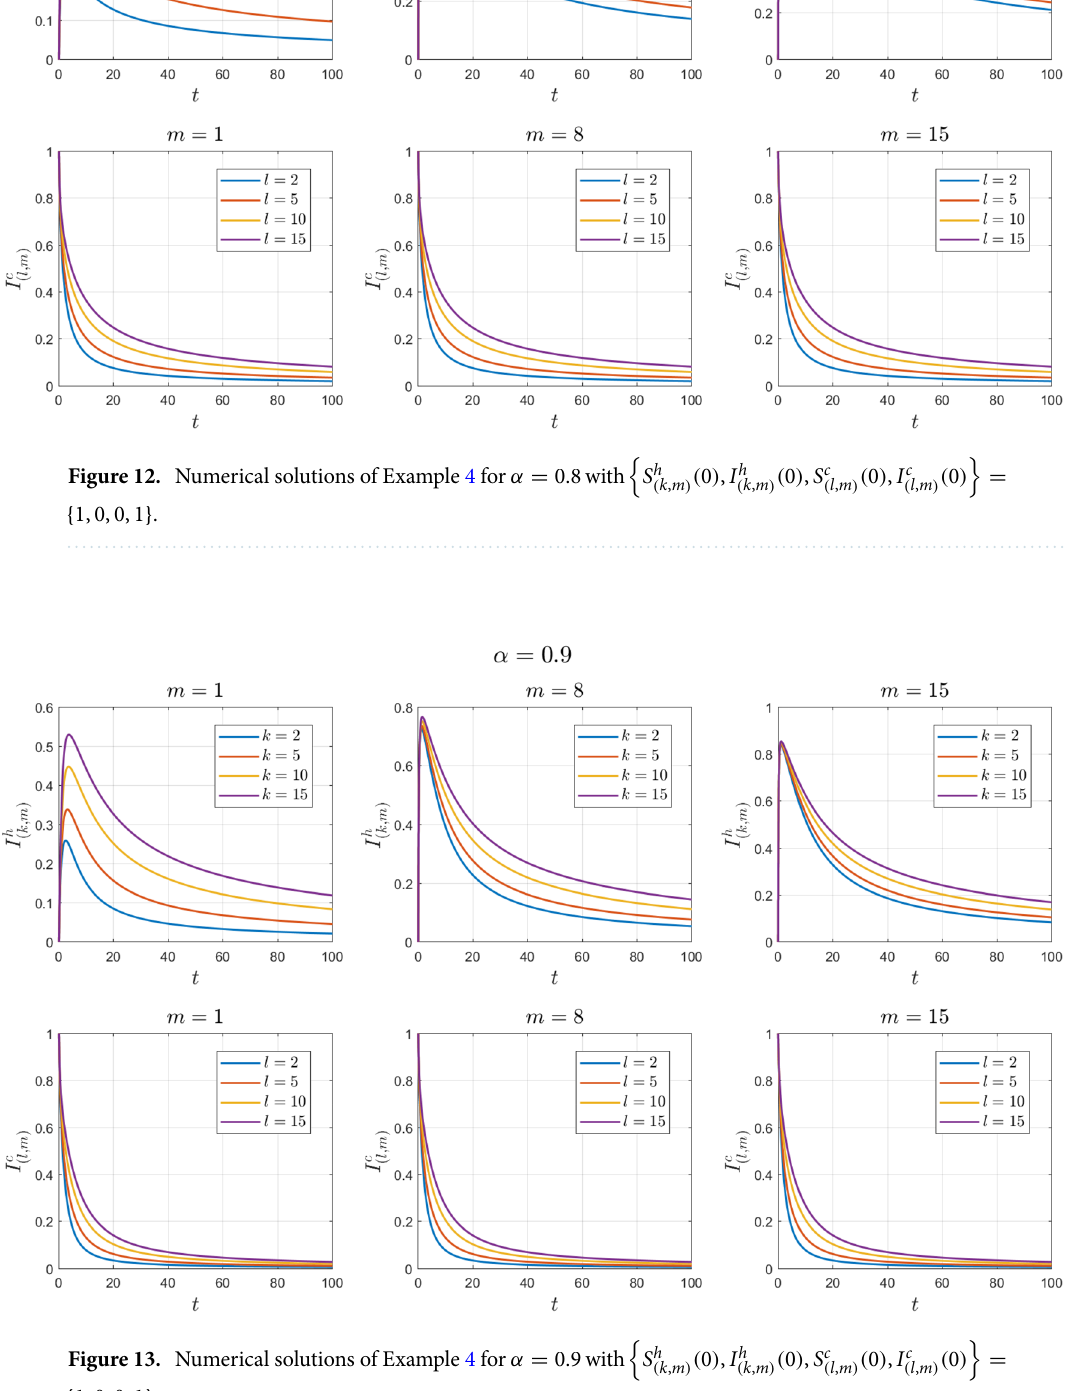
Figure 13. Numerical solutions of Example 4 for α = 0.9 with { 1, 0, 0, 1 }